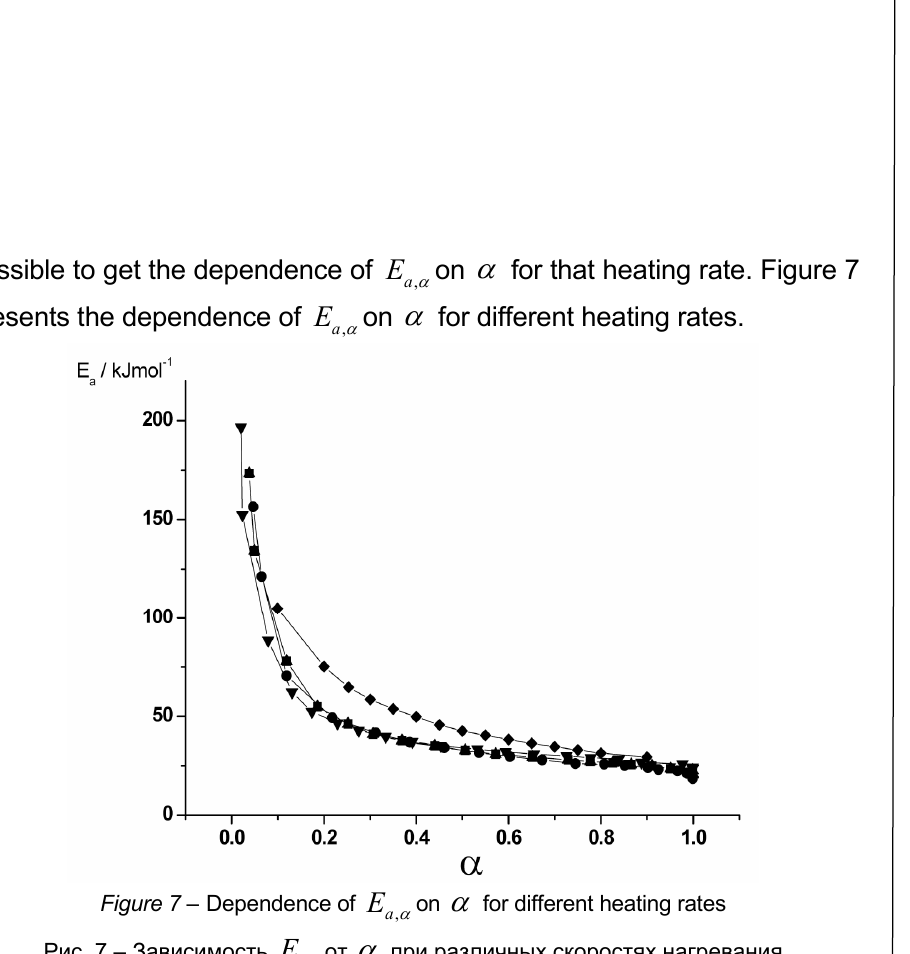
Figure 7 – Dependence of Рис . 7 – Зависимость Слика 7 – Зависност